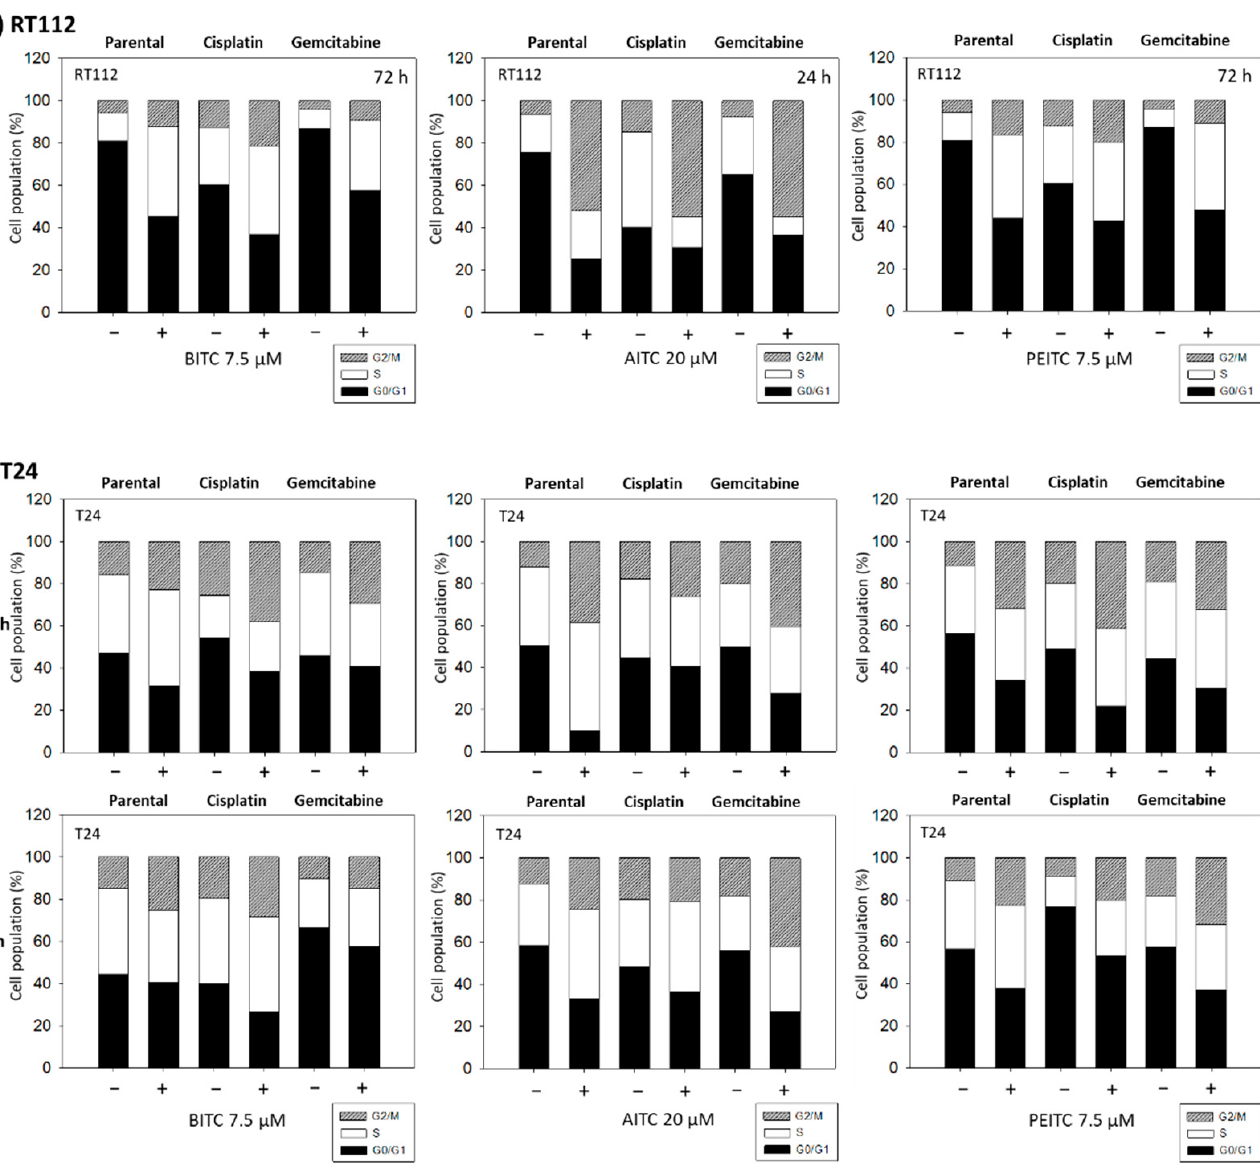
Figure 7. Cell cycle distribution in parental, cisplatin- or gemcitabine-resistant RT112 ( A ) and T24 cells ( B ) following BITC (7.5 µM), AITC (20 µM) or PEITC (7.5 µM) exposure for 24 and/or 72 h. Controls ( − ) remained untreated. “+” indicates drug treatment. One representative of three separate experiments is shown.